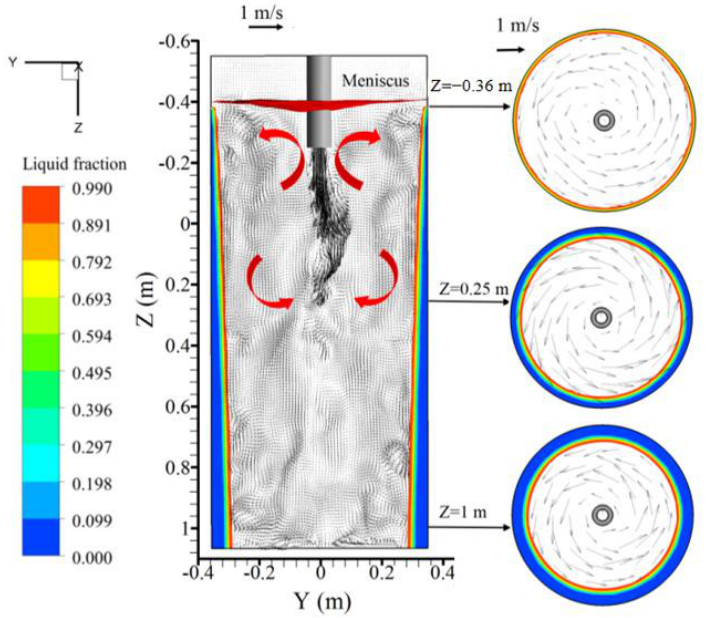
Figure 8. Transient vectors and solidification shell growth at conditions of 310 A/2.5 Hz.